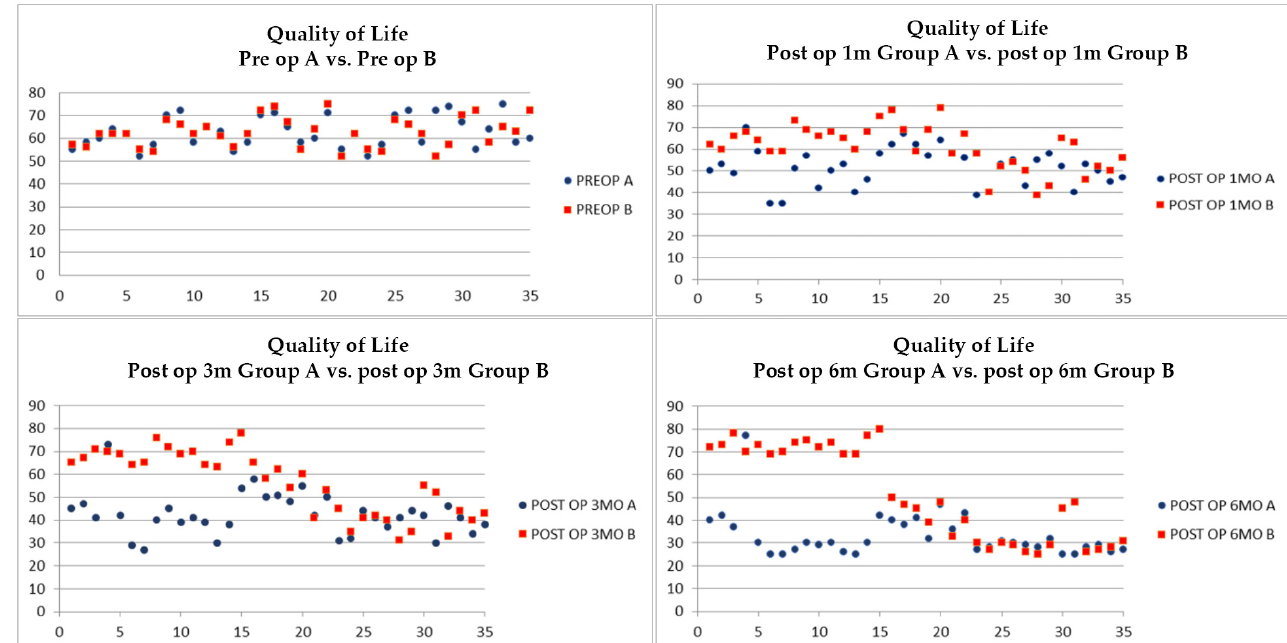
Figure 7. Quality of life assessment at T0 ( upper-left ), T1 ( upper-right ), T2 ( lower-left ) and T3 ( lower-right ). When confronting the two groups the mean values shows a marked QoL improvement in group A and a slight improvement in group B (Figure 8).